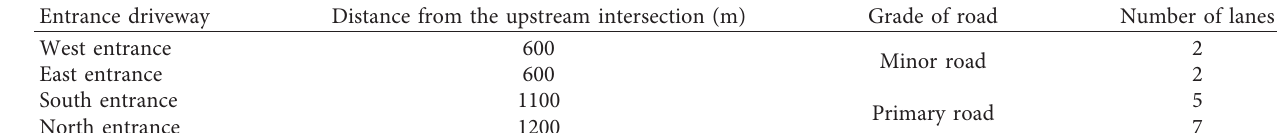
Table 2: The condition of each entrance at the intersection.